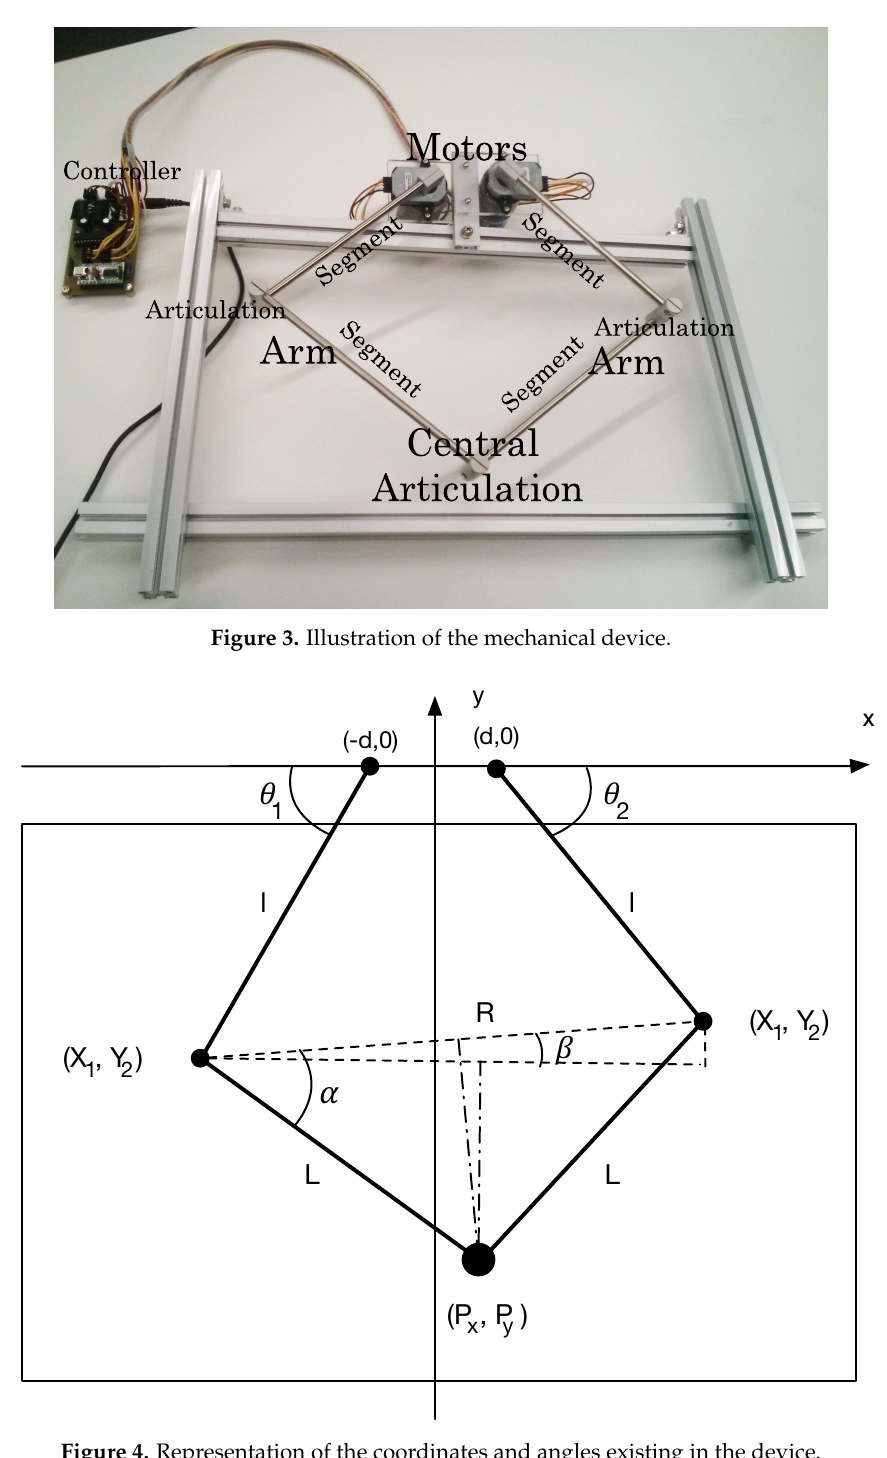
Figure 4. Representation of the coordinates and angles existing in the